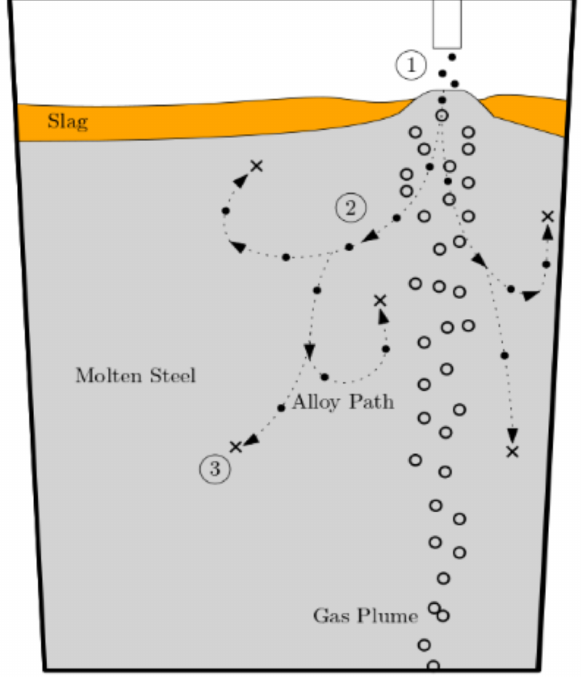
Figure 1. Injection process: ( 1 ) alloy entrance; ( 2 ) shell formation and melting; ( 3 )